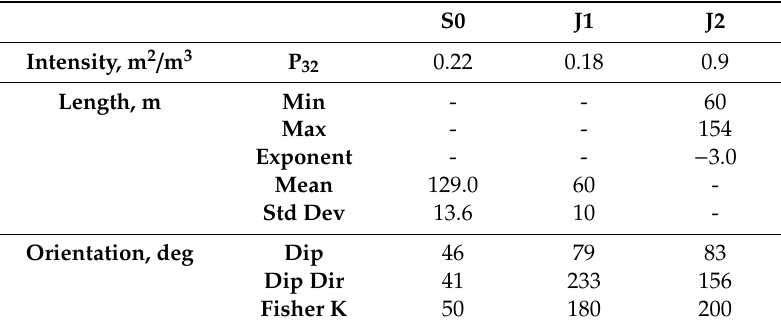
Table 4. Characteristics of discontinuity sets used to develop DFN